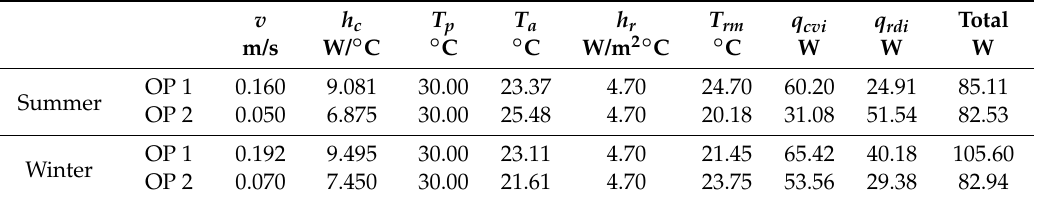
Table 6. The individual heat transfer in the summer regime in the living room.